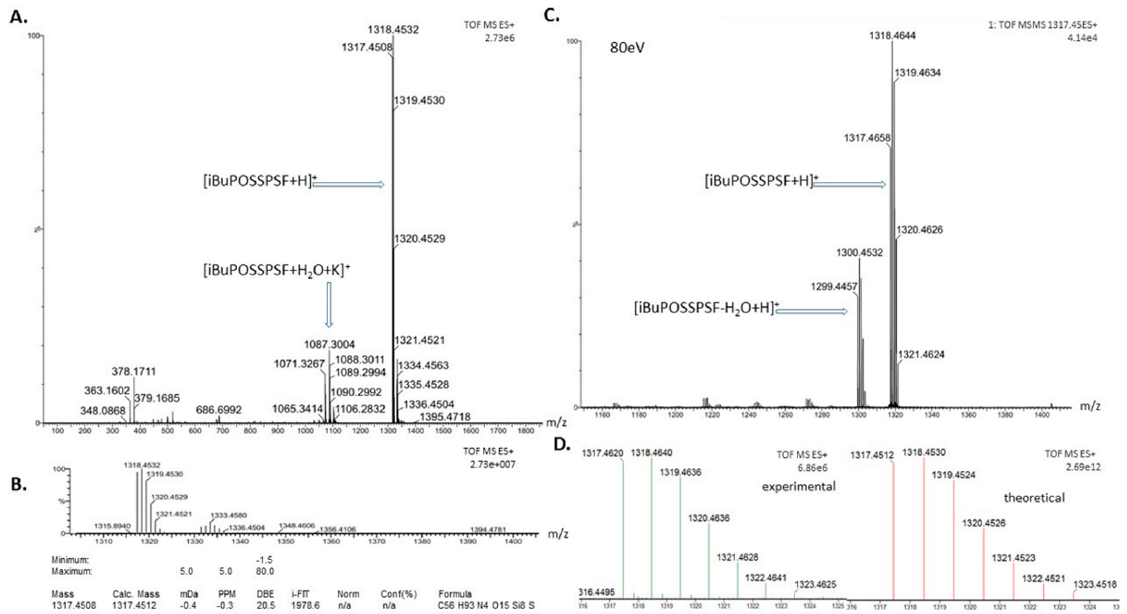
Figure 4. Analysis of the iBuPOSS-PSF conjugate by an electrospray source in positive mode by mass spectrometer with TOF analyzer in ( A ); ESI (+)—HRMS analysis in ( B ); spectrum of iBuPOSSPSF fragmentation experiments ( m / z 1317.45), collision energy was 80 eV in ( C ); simulated spectrum [C 56 H 94 N 4 O 15 Si 8 S + H] + (red line) and experimental (green lines) in ( D ).